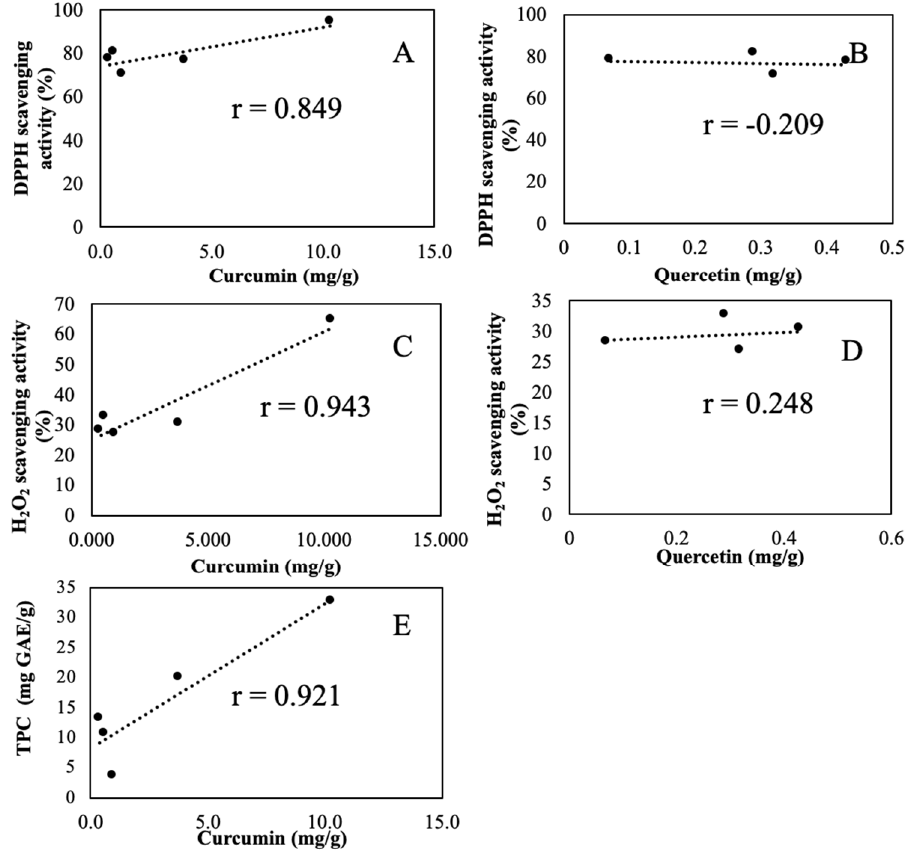
Figure 6. Pearson correlation scatter plots of relationship between ( A ) AA and curcumin, ( B ) AA and quercetin, ( C ) AA (H 2 O 2 ) and curcumin ( D ) AA (H 2 O 2 ) and quercetin, and ( E )TPC and curcu- min.